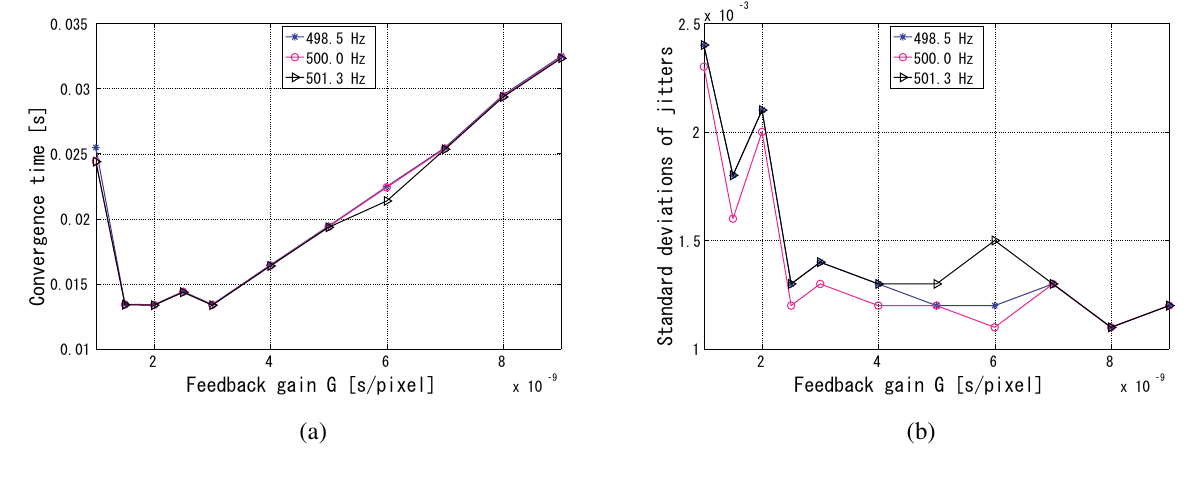
Performance evaluation of the simulation results, (a) convergence time of different gains versus the gain of the input signal, (b) phase jitters versus the gain of the input signal.